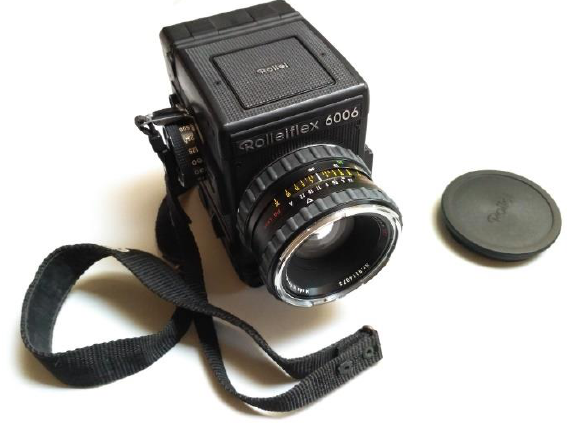
Figure 4. Camera Rollei 6006